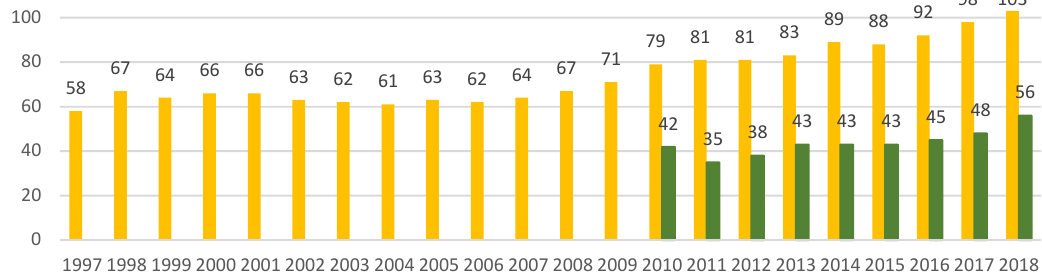
Figure 1. Evolution of the energy and fuels category and its relationship with MDPI’s Energies journal.